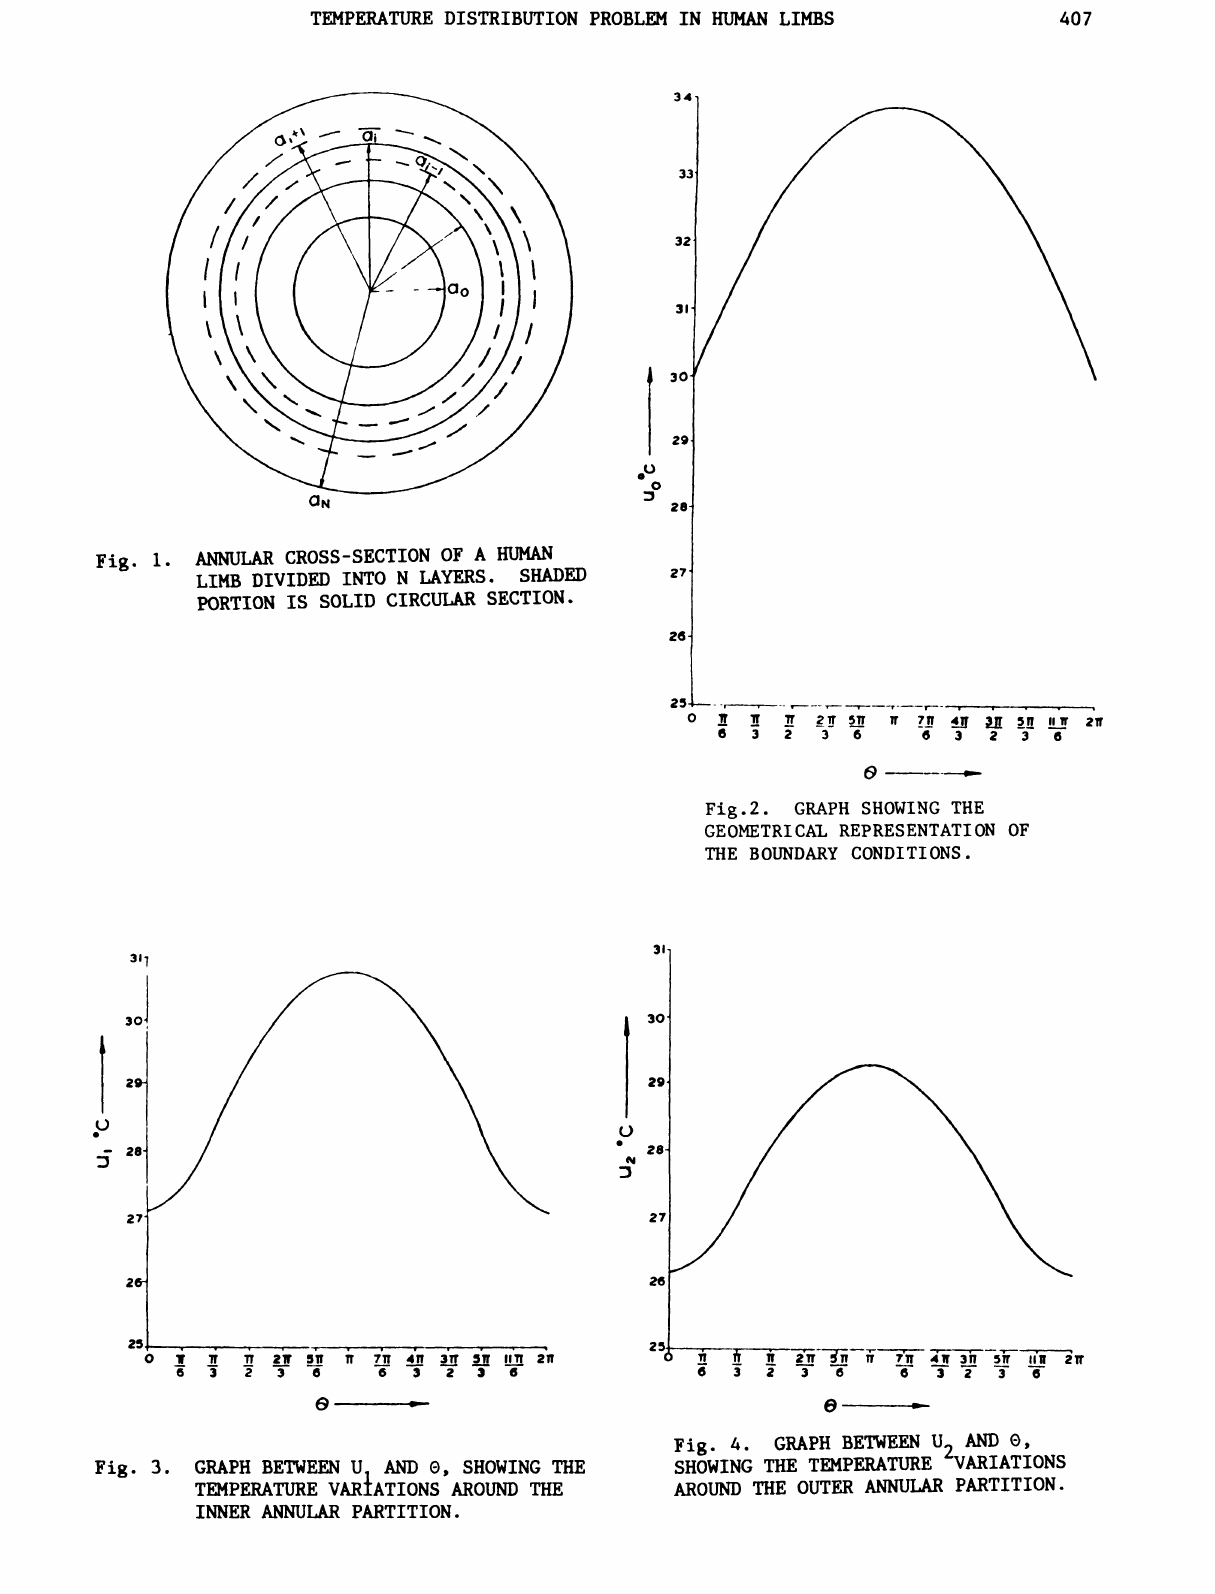
Fig. 4. GRAPH BETWEEN UgAND SHOWING THE TEMPERATURE -VARIATIONS Fig. 3. GRAPH BETWEEN U. AND (R), SHOWING THE VARIATIONS TEMPERATURE AROUND THE OUTER ANNULAR AROUND THE INNER ANNULAR PARTITION.